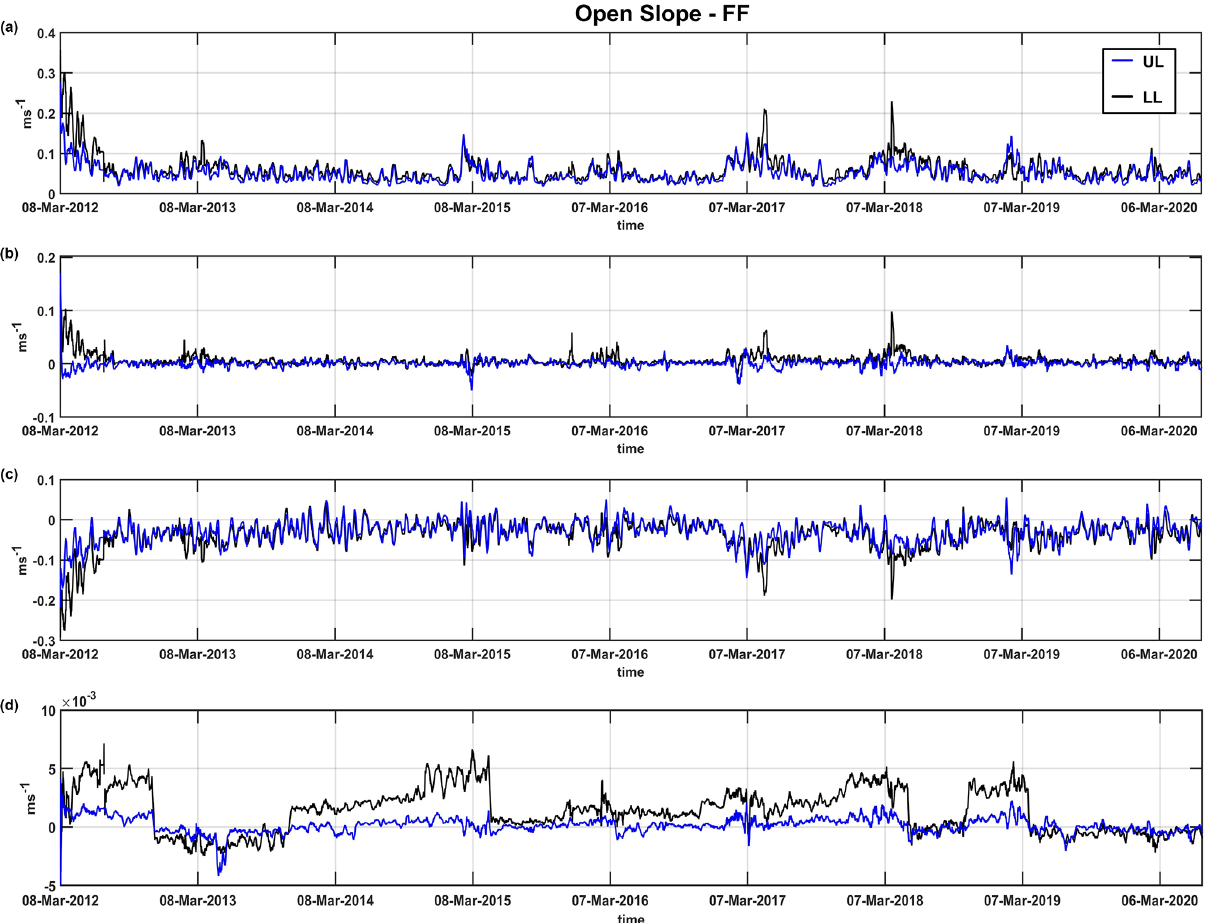
Figure 11. Time series of currents at FF site in the upper (UL) and lower layer (LL) of the water column: (a) speed, (b) east, (c) north and (d) vertical components – FF. The data are presented with a 7d smoothing